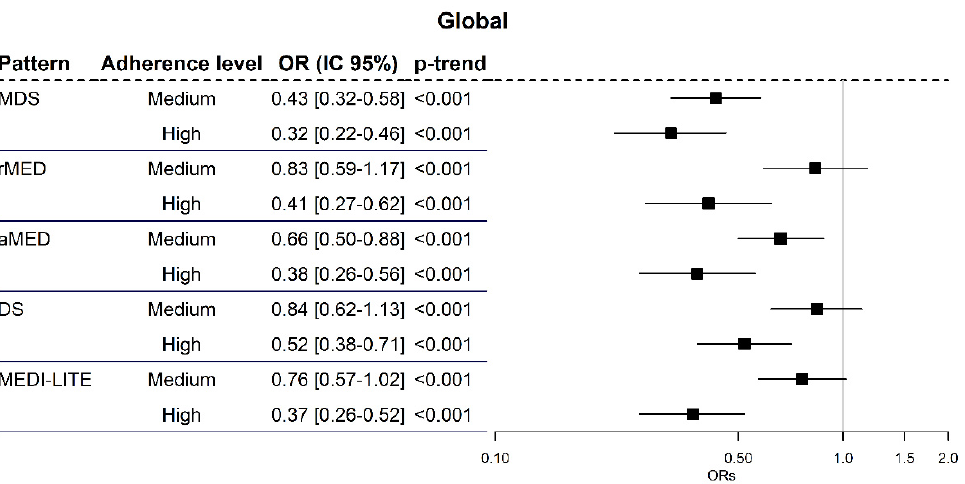
Figure 1. Odds ratios of risk of gastric cancer according to adherence level to various rates compared with low adhesion.